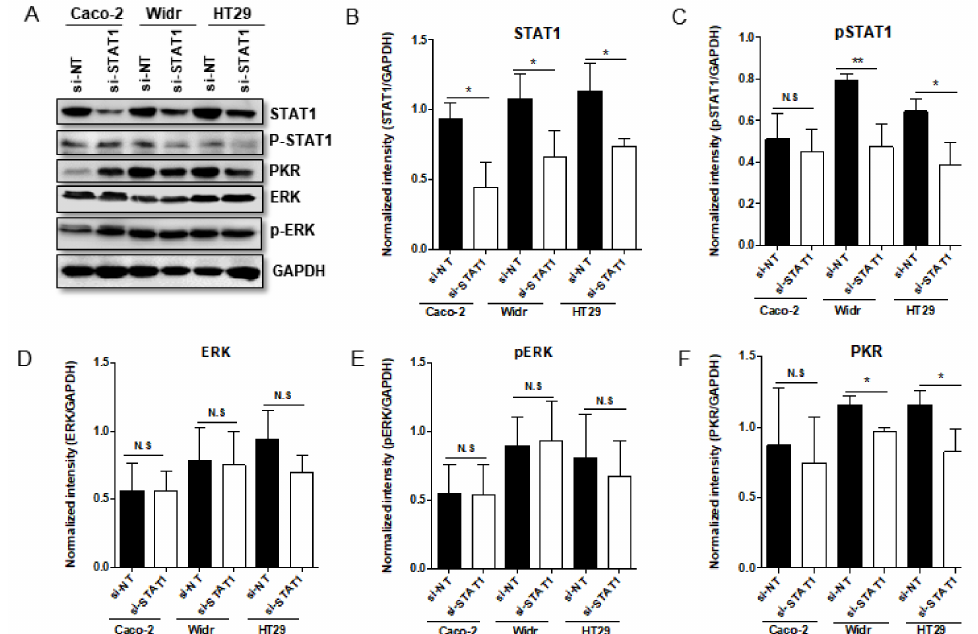
Figure 3. Knockdown of STAT1 in Caco-2, Widr and HT29 cells by siRNA. Panel ( A ) Caco-2, Widr, and HT29 cells were either transfected with 100 nM STAT1 siRNA or nontarget siRNA (siNT). The cells were harvested at 72 h after transfection. The proteins were electrophoretically separated in a 10% denaturing gel and reacted with indicated antibodies. Panel ( B – F ) Quantification of the protein level of STAT1, pSTAT1, ERK, pERK, and PKR in Caco-2, Widr, and HT29 cells when Knockdown of STAT1 by siRNA. N.S. (not significant); p > 0.05, * p < 0.05, ** p <